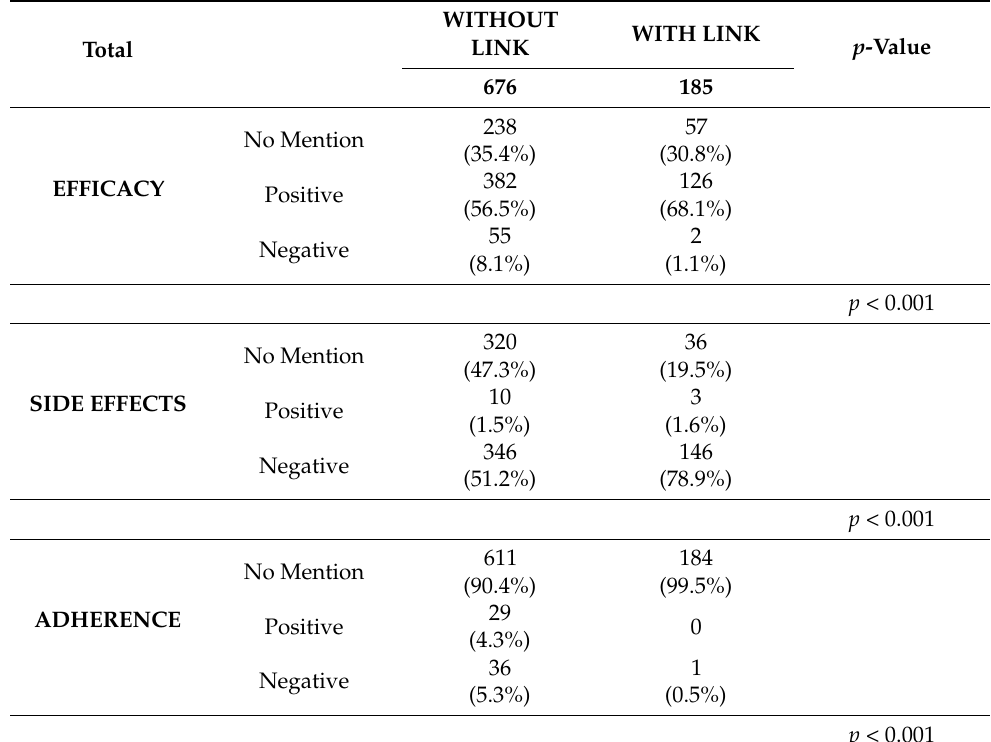
Table 3. Descriptive characteristics of the tweets considered classifiable in the content analysis, categorized by either including or not including a link.